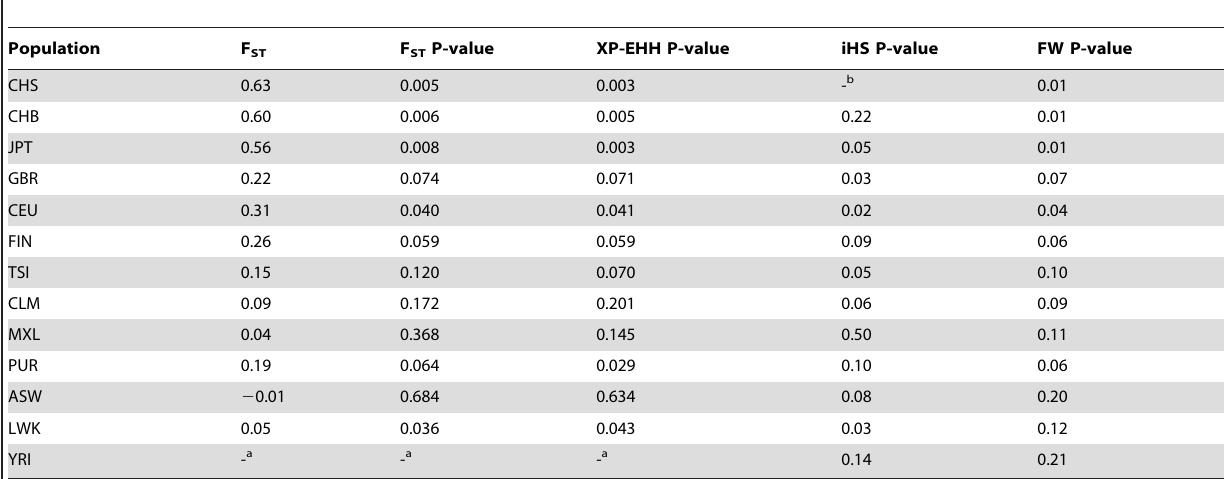
Table 1. F ST values and for F ST , XP-EHH, iHS and Fay and Wu’s H (FW) the empirical P-values are shown for rs368234815 in every